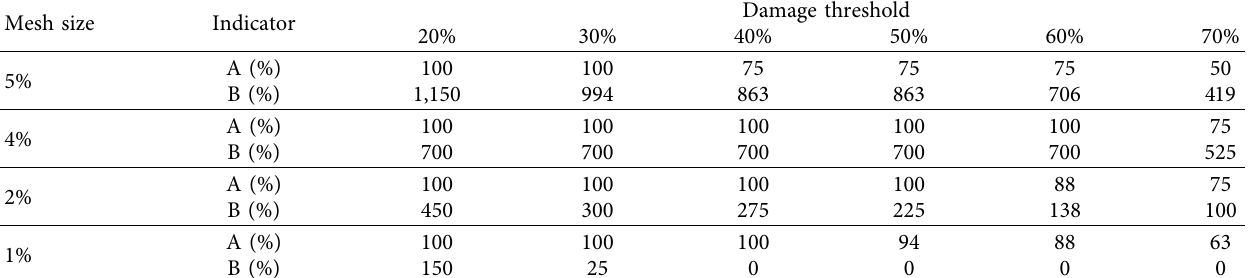
Table 6: Damage capacity indicators (%) for local MSE procedure.